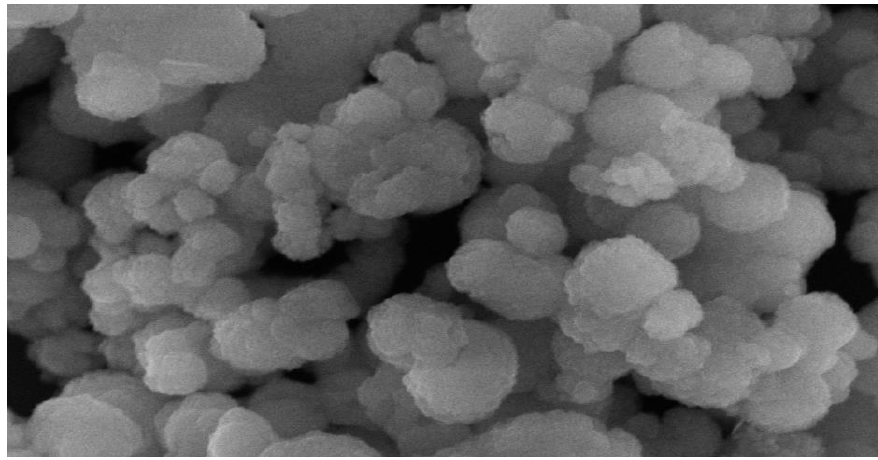
Figure 3. SEM image of nanoparticle complex.